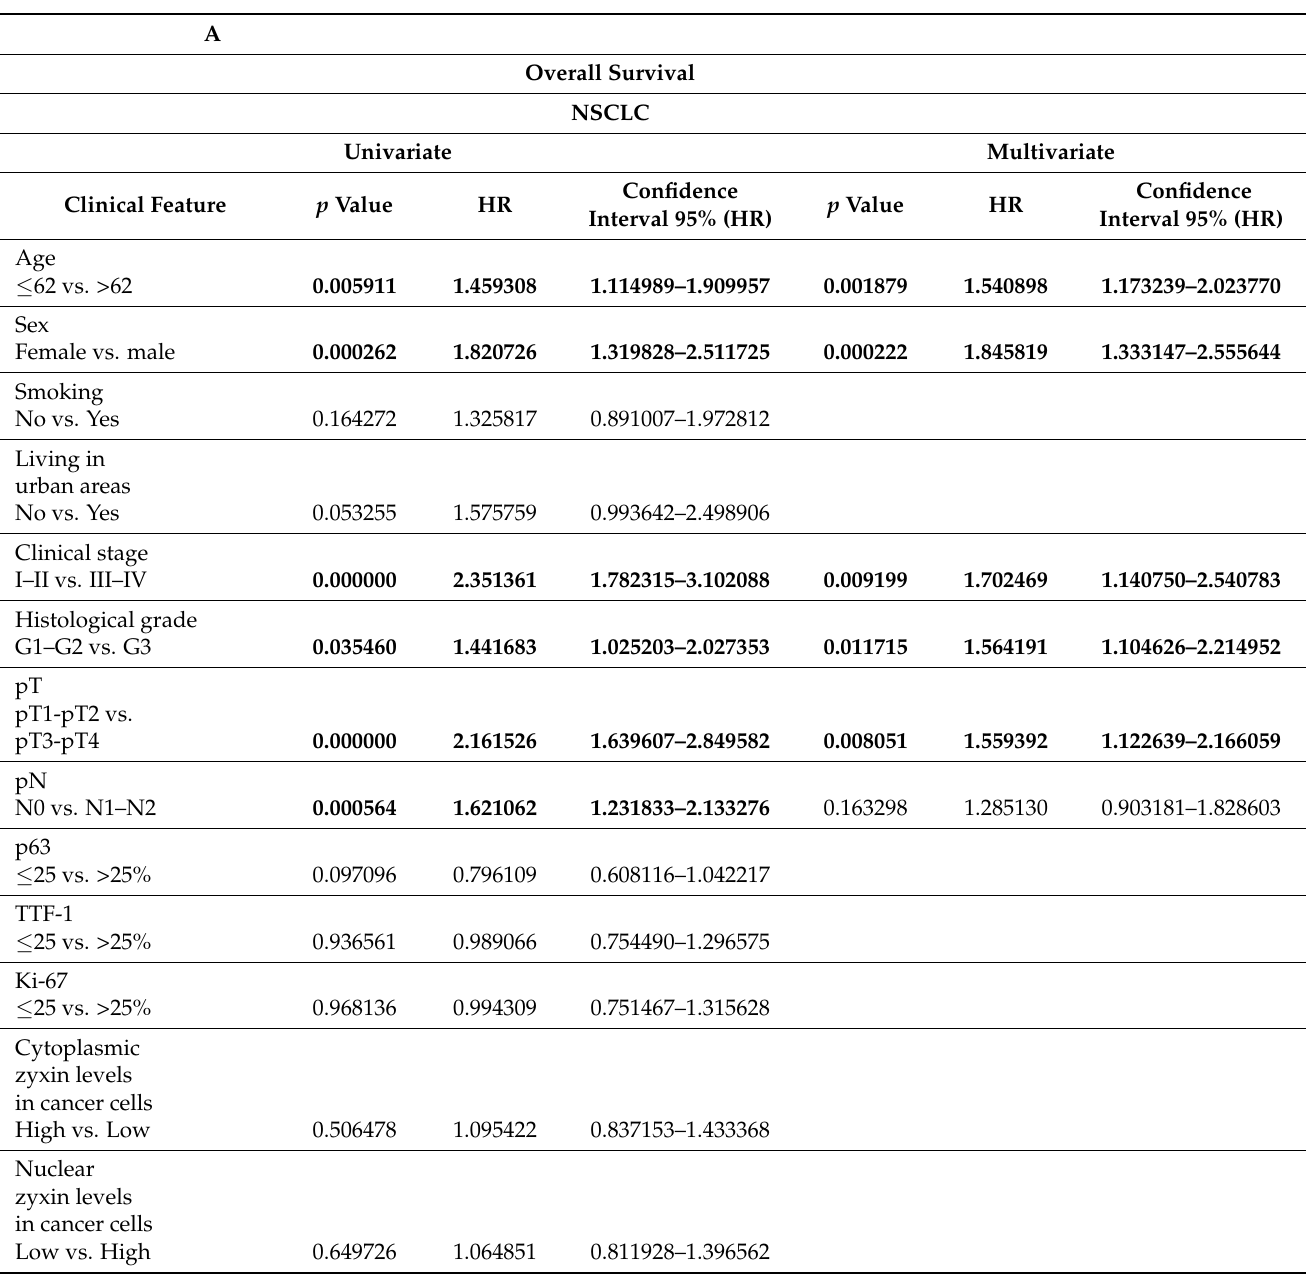
Table 3. Survival analysis of patients with NSCLC (A), SCC (B), and AC (C). The analyses were performed using Cox proportional hazards